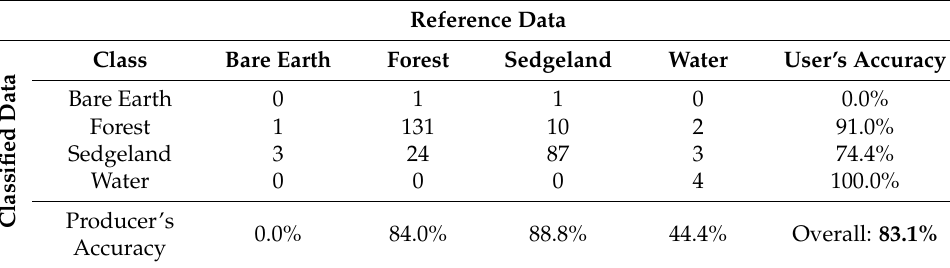
Table 7. Confusion matrix for Combined data stream describing vegetation